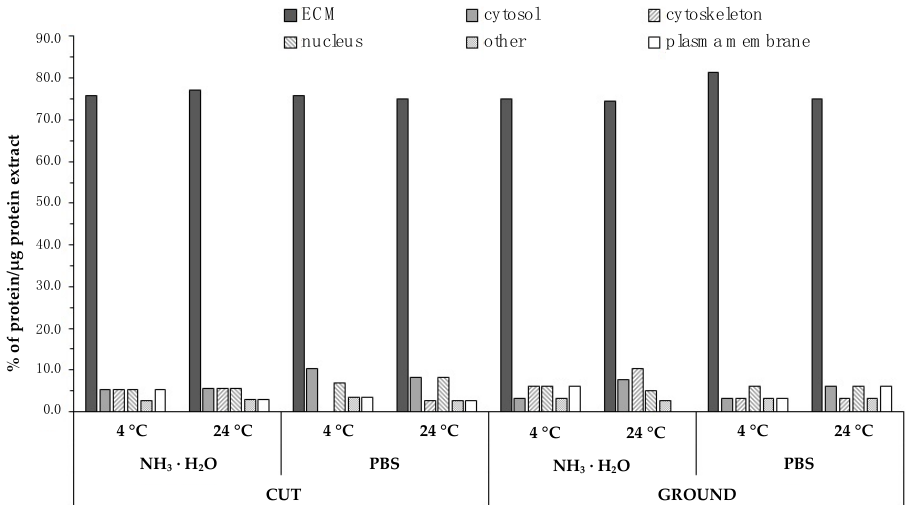
Figure 2. Microscopic image of DAPI staining of native tissue (( a ); scale: 100 µ m) and decellularized tissue (( b ); scale: 500 µ m).